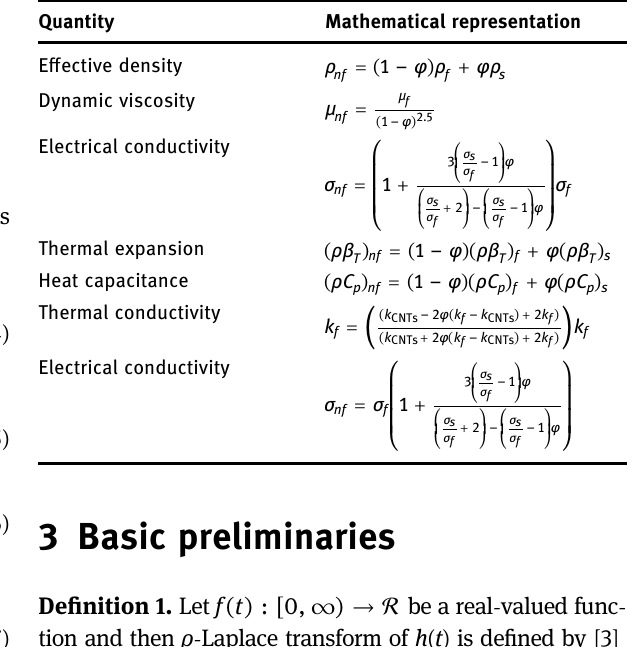
Table 2: Thermophysical